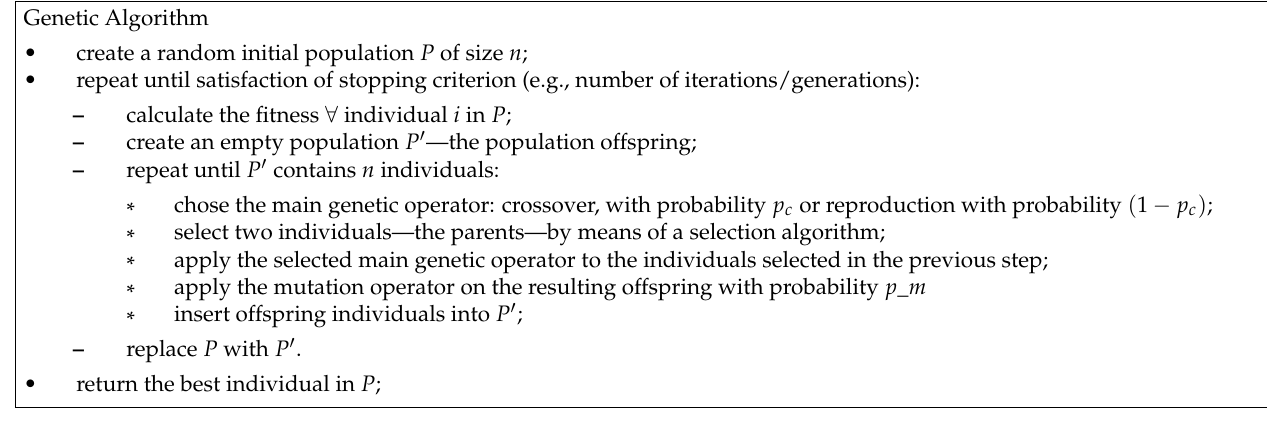
Figure 5. Procedural steps of the genetic